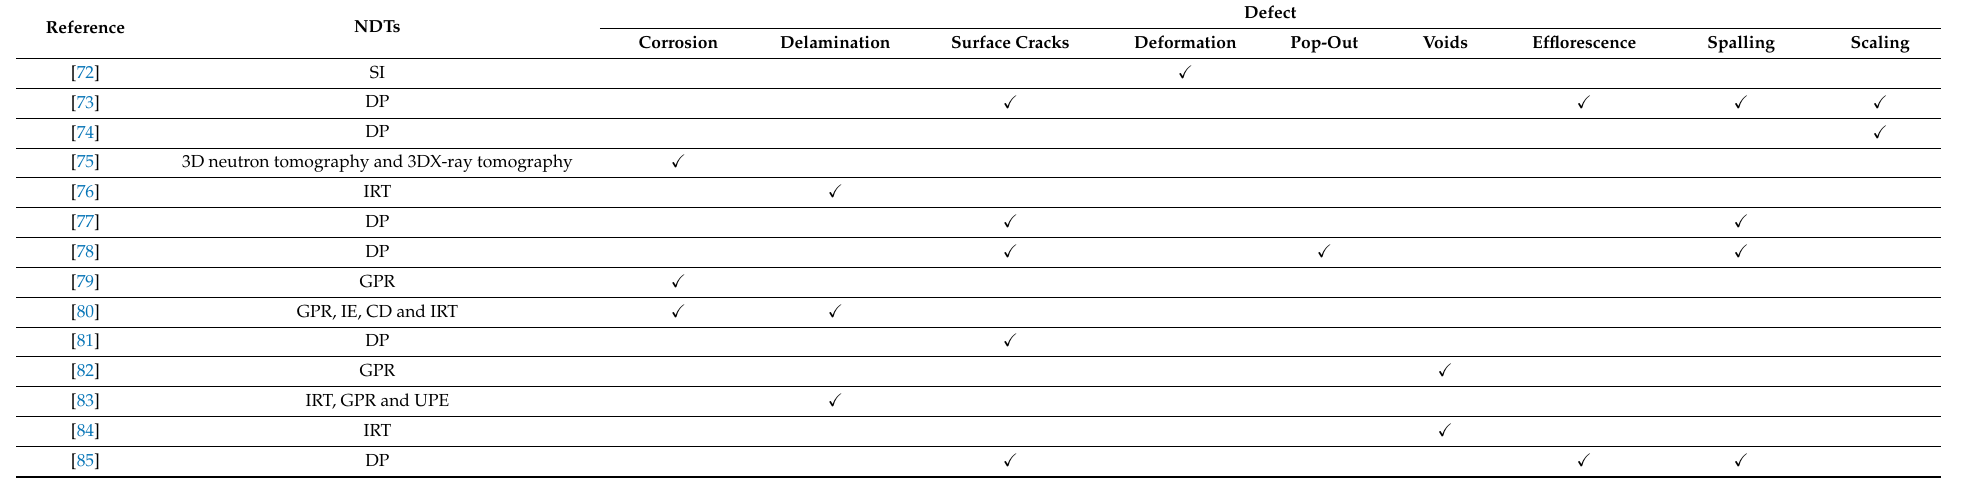
Table 9. Description of some of the studies in the research domain of CBD_NDT